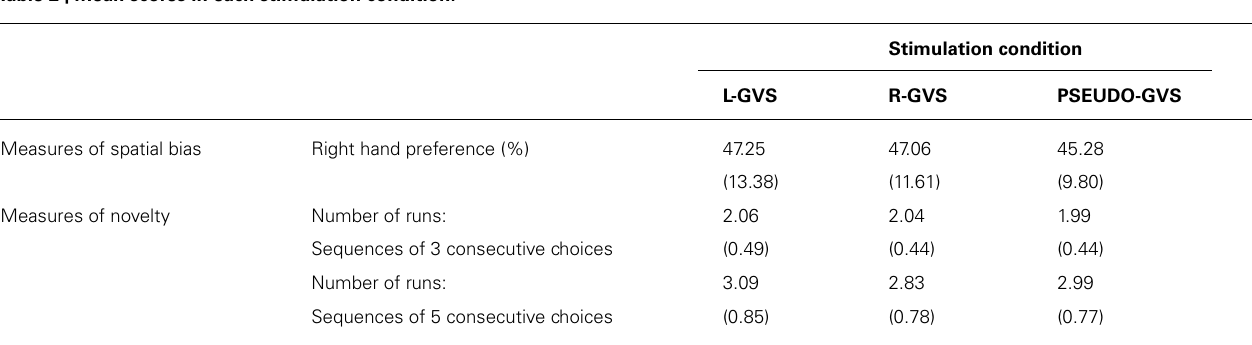
Table 2 | Mean scores in each stimulation